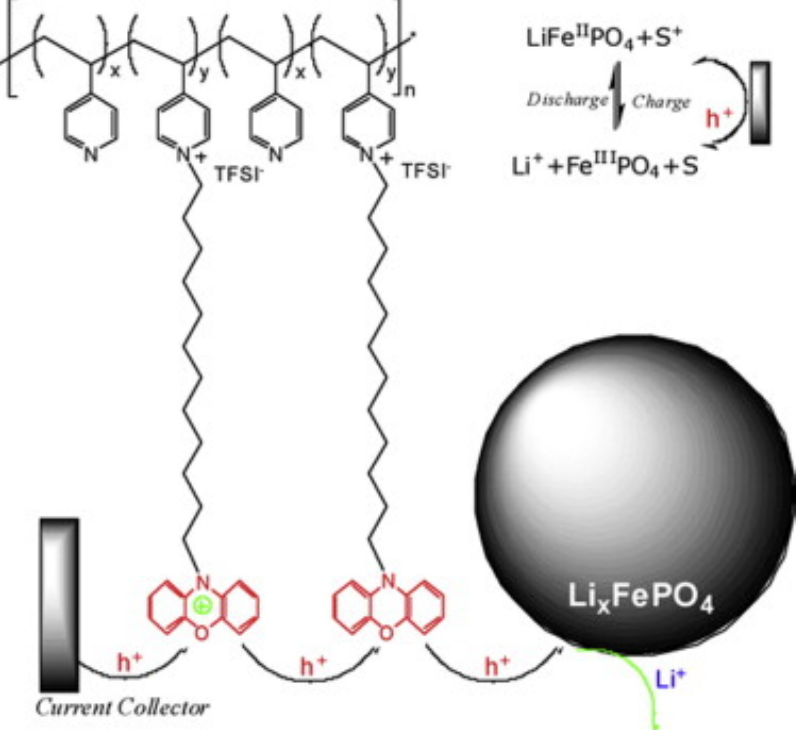
Figure 5. Schematic model showing the working principle of polymer wiring of insulating electrode materials. Here, carbon-free LiFePO 4 was studied with redox polymer poly(4-((10-(12-dodecyl phenoxazine) vinylpyridinium)-co-4-vinylpyridine) in a molar ratio of 6:1 ( y / x = 5) [81]. Reprint with permission from [81]; Copyright 2009, Elsevier.